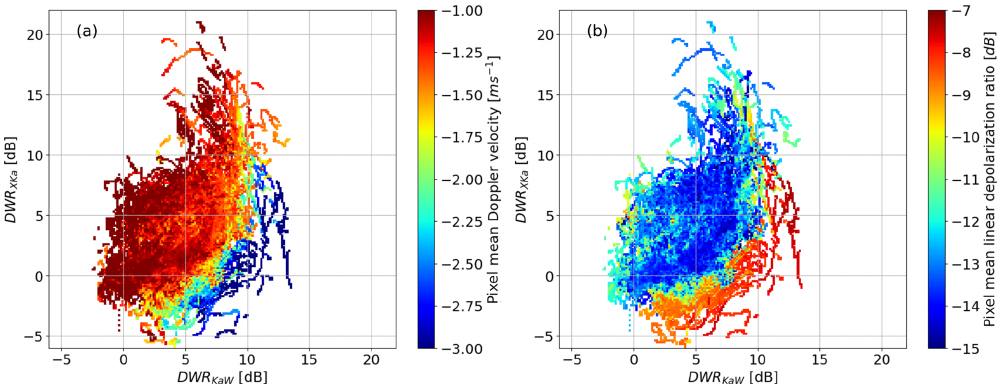
Figure 13. Triple-frequency diagrams of observations between 0 ◦ C and the LDR maximum in the melting layer (same as Fig. 10c), but the color in (a) indicates the average MDV, while in (b) the color shows the average LDR.